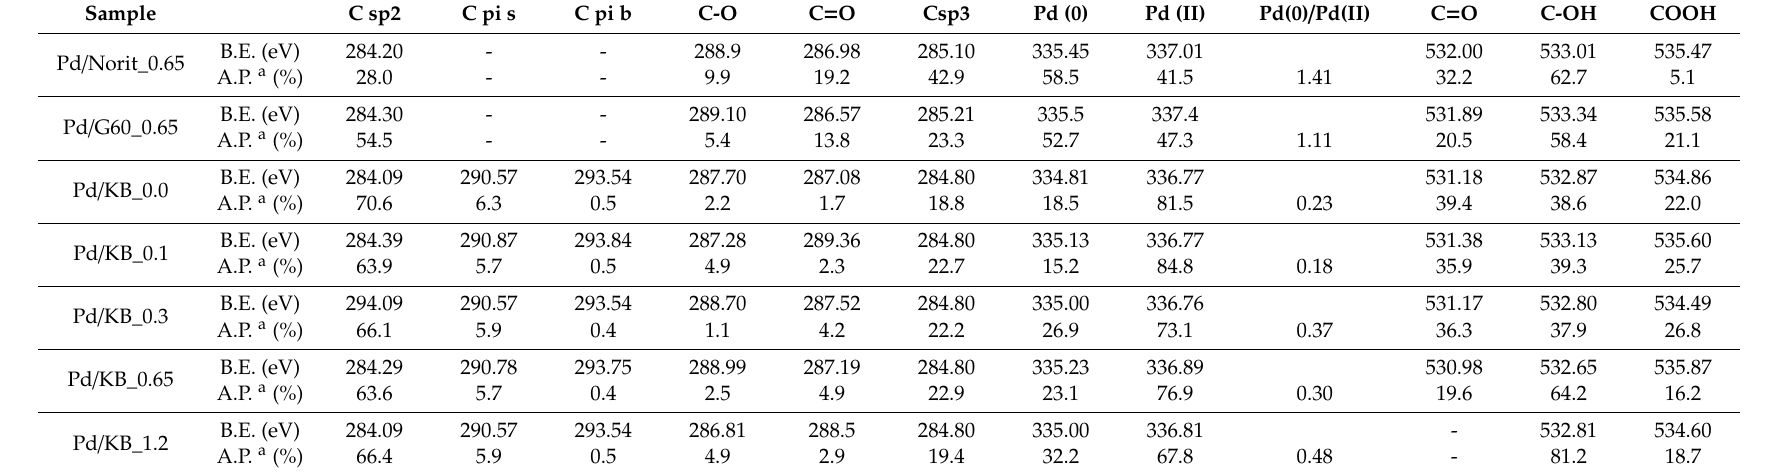
Table 5. C, Pd, and O species detected from XPS